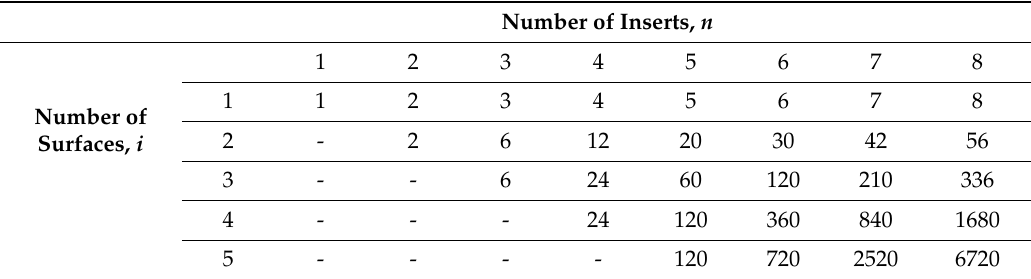
Table 1. Number N of different profile of machined surface calculated using Equation (1).